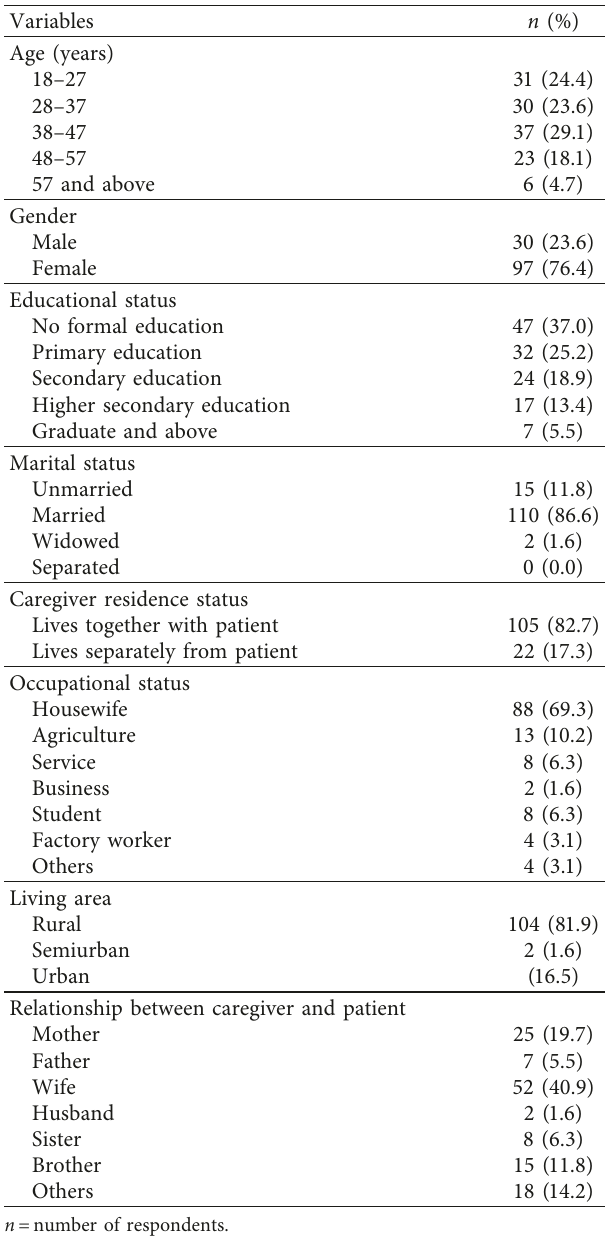
Table 1: Sociodemographic characteristics of the caregivers ( n �